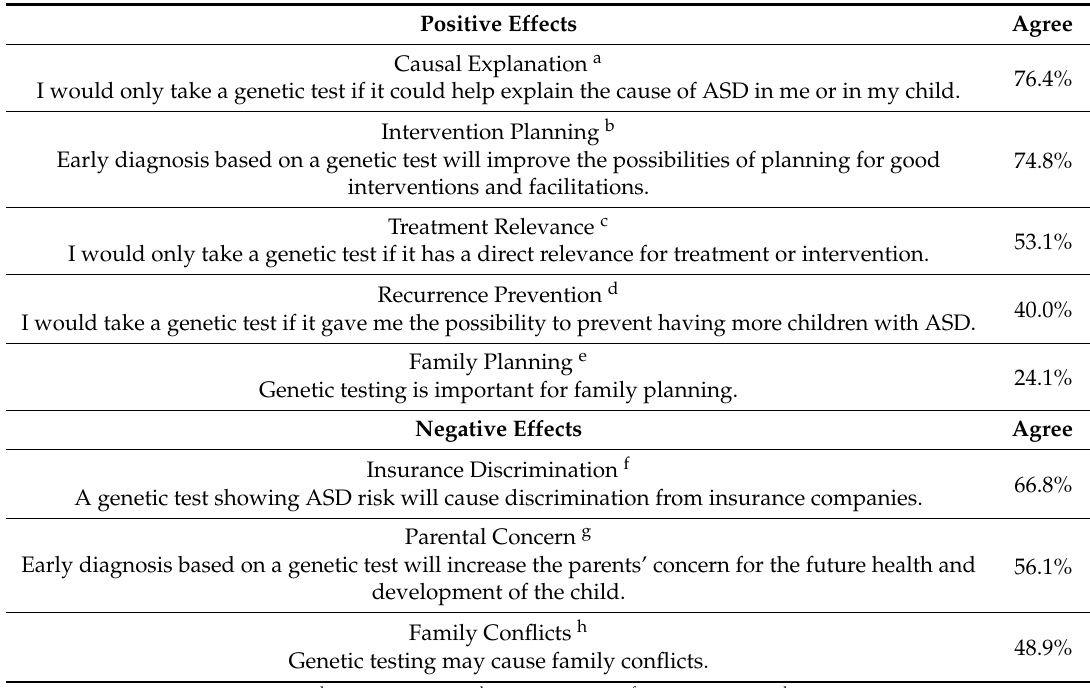
Table 2. Parents’ opinions on possible effects of CGT for ASD ( n =